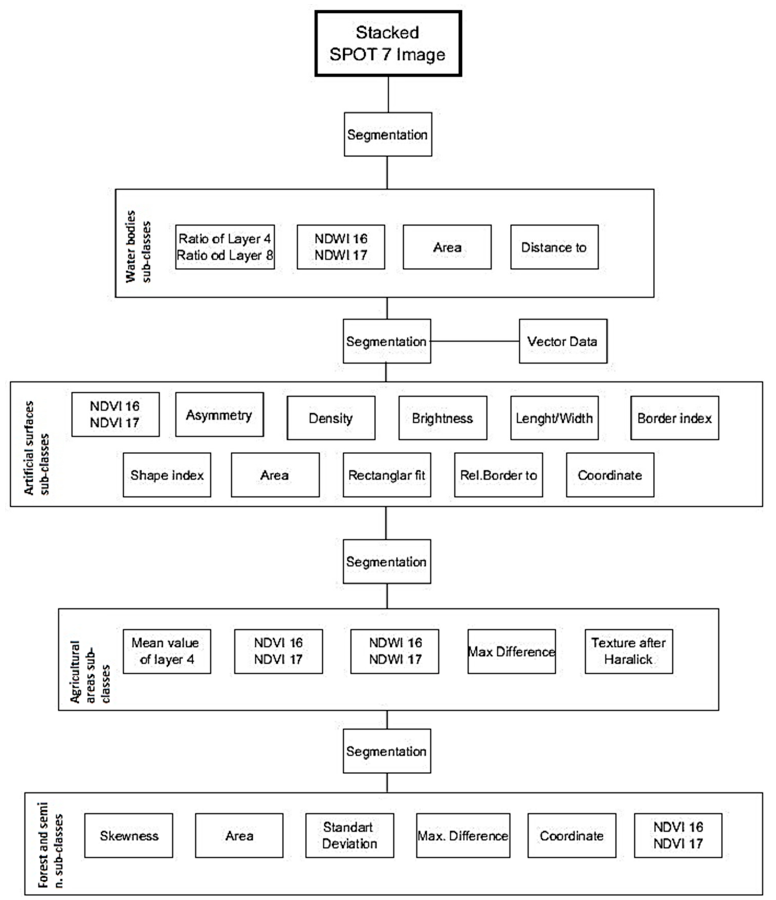
Figure 3. Flowchart of the classification process.